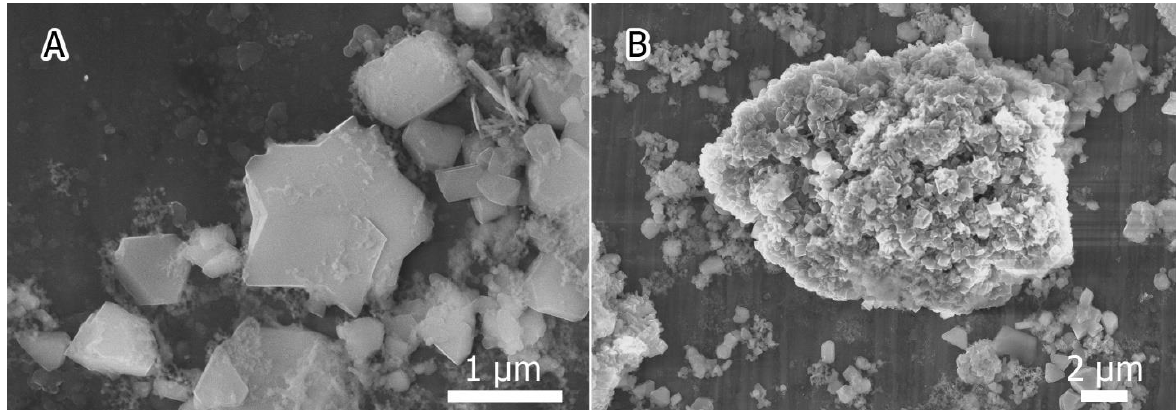
Figure 2. Faceted crystallites observed in Si:Se sample: ( A ) truncated octahedrons; ( B ) recrystallized nanosilicon.